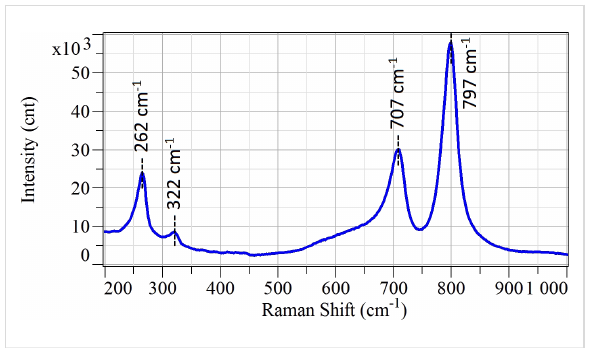
Figure 6: Raman spectrum performed on WO 3 nanowire deposited on alumina substrate measured in ambient air at room temperature. Hydrothermal technique: Nb 2 O 5